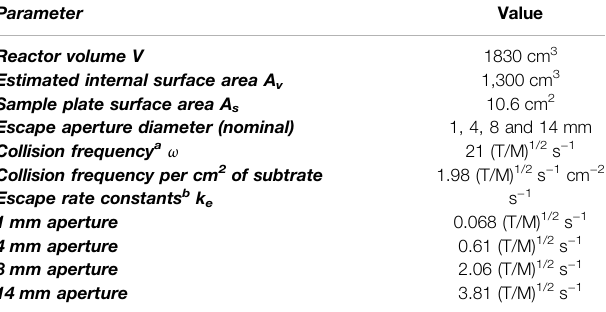
TABLE 2 | Parameters of the four aperture Knudsen fl ow reactor used most recently (since 1994). Parameter